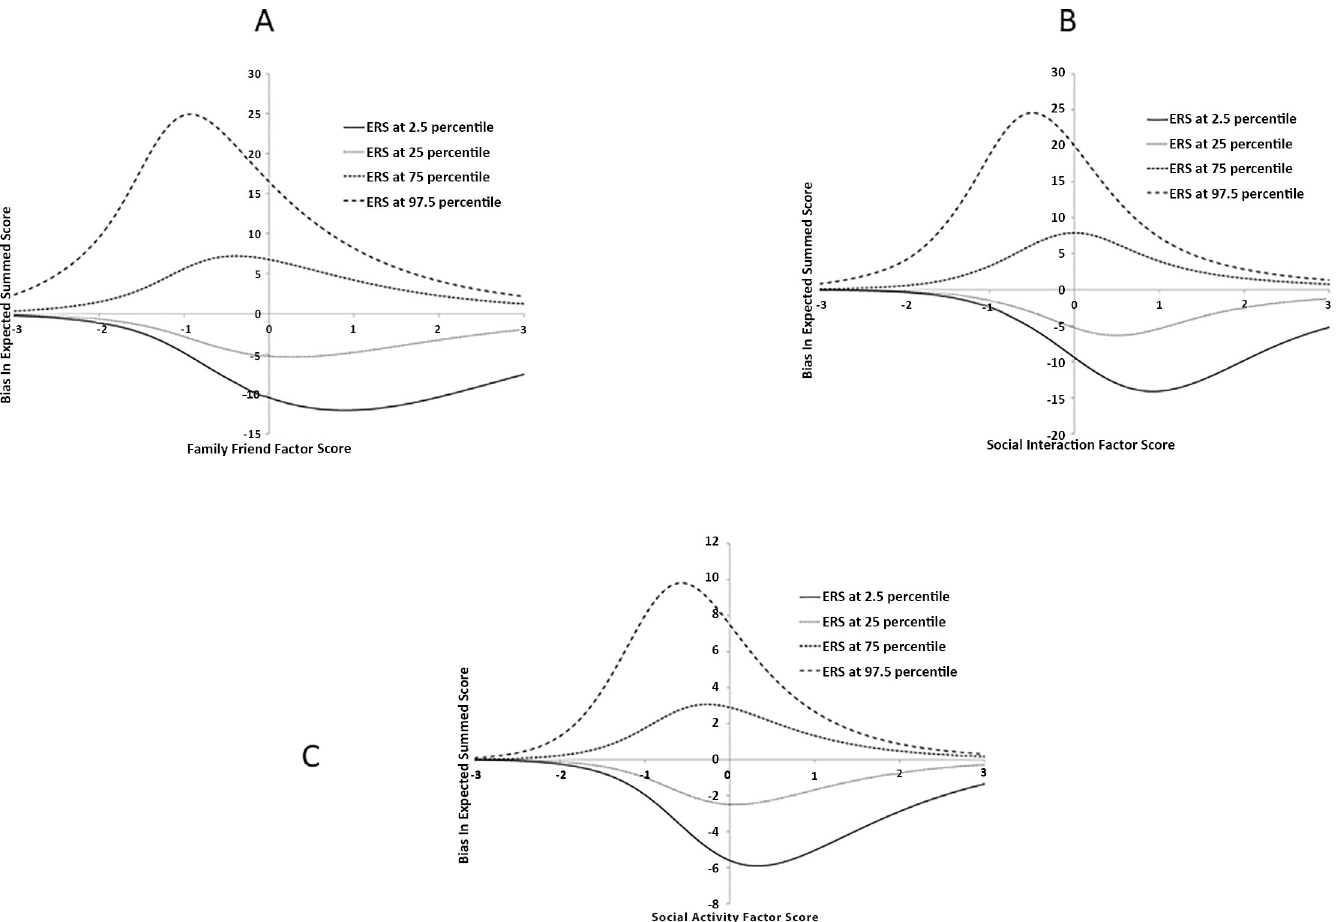
Fig 2. The expected summed score bias at difference PERS levels across the substantive factor score range. Family Friend Factor. (B) Social Interaction Factor. (C) Social Activity Factor.